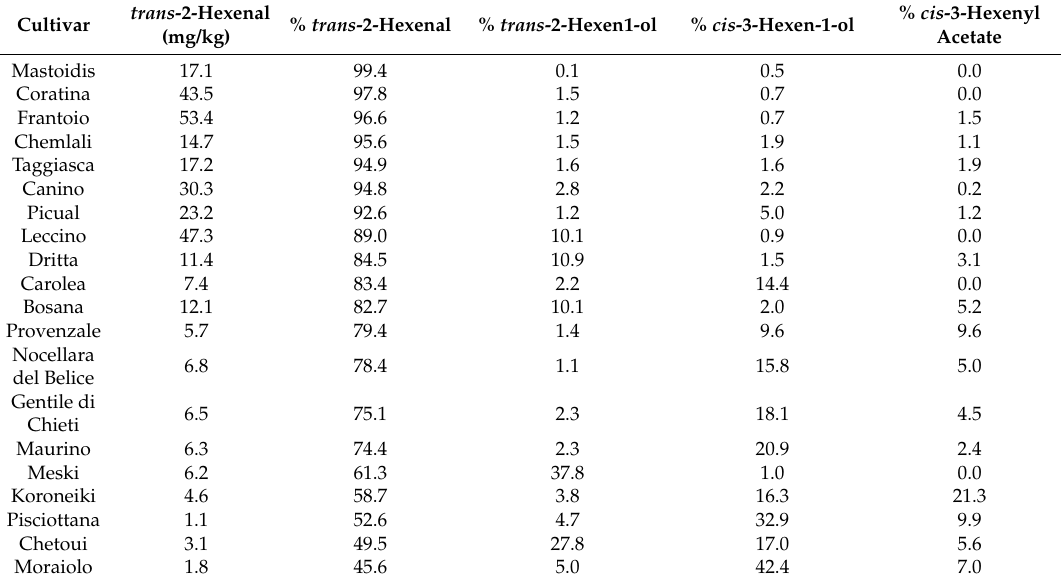
Table 4. trans -2-Hexenal as mg/kg, and percent distribution of the main metabolites coming from LnA oxidation in some extra virgin monovarietal olive oils. Results are expressed as mean of three samples of each monovarietal olive oil. (Source: the authors, unpublished